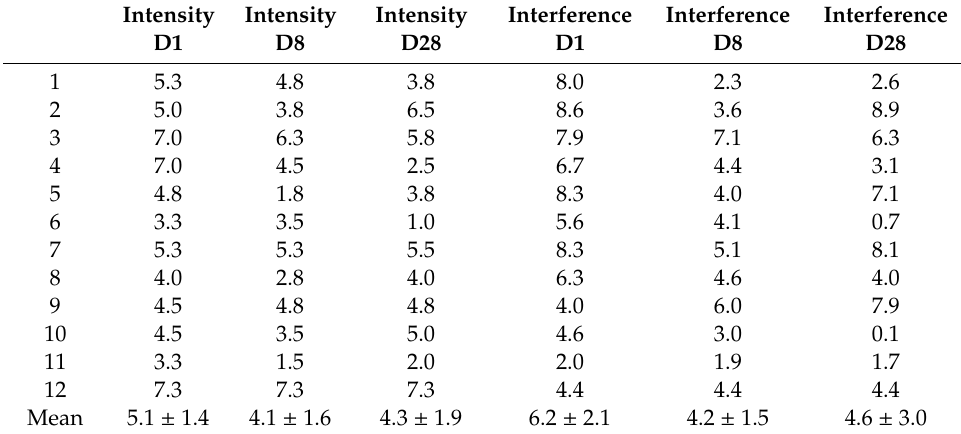
Figure 2. Evolution of daily pain over time for the five patients with more than 10% reduction at day 8 (D8), day 1 corresponding to the first rTMS session. Pain is noted out of 100.